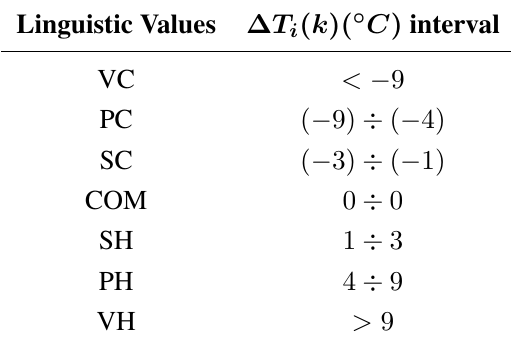
Table 7. Membership function ∆ T